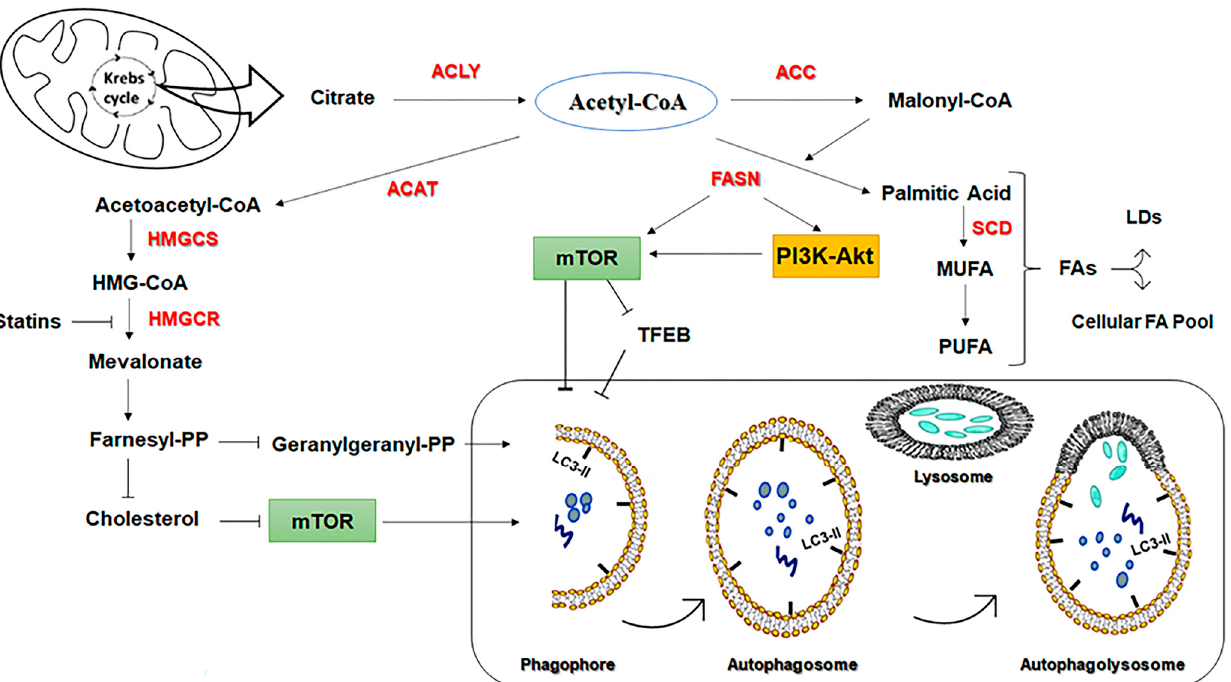
Figure 6. Mechanism of action of autophagy regulation upon HMGCR inhibition by statins. In ad- dition, the mechanism by which FASN can modulate autophagy during cancer is shown.